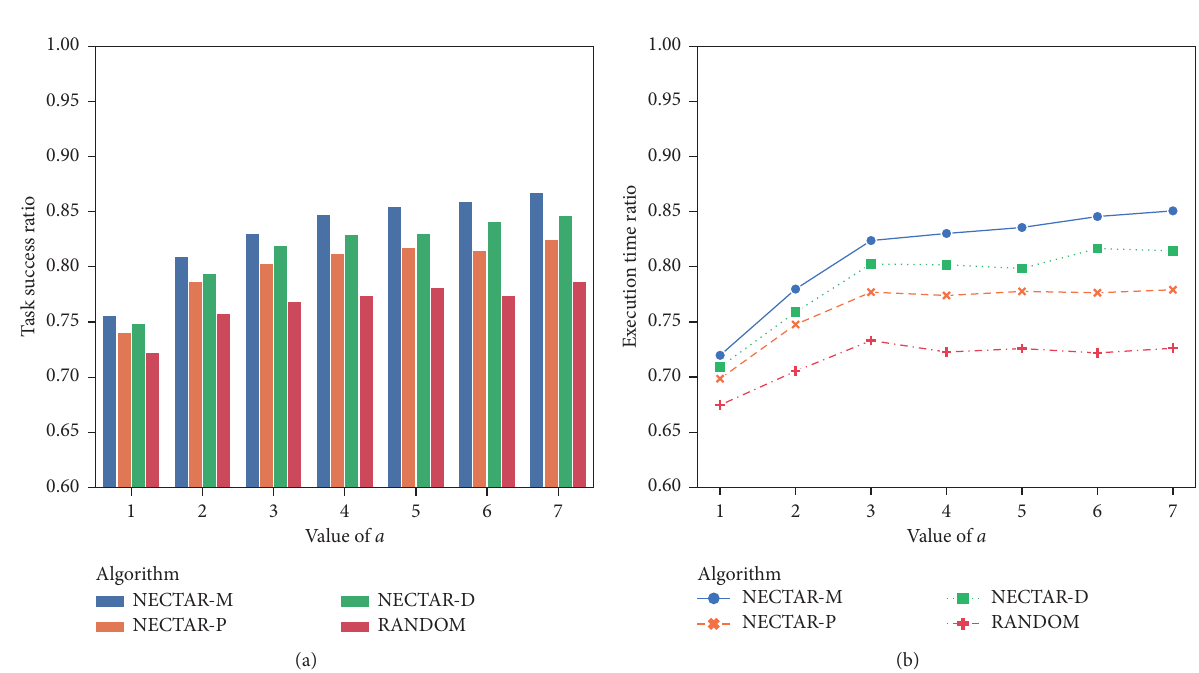
Figure 6: Performance impact of task